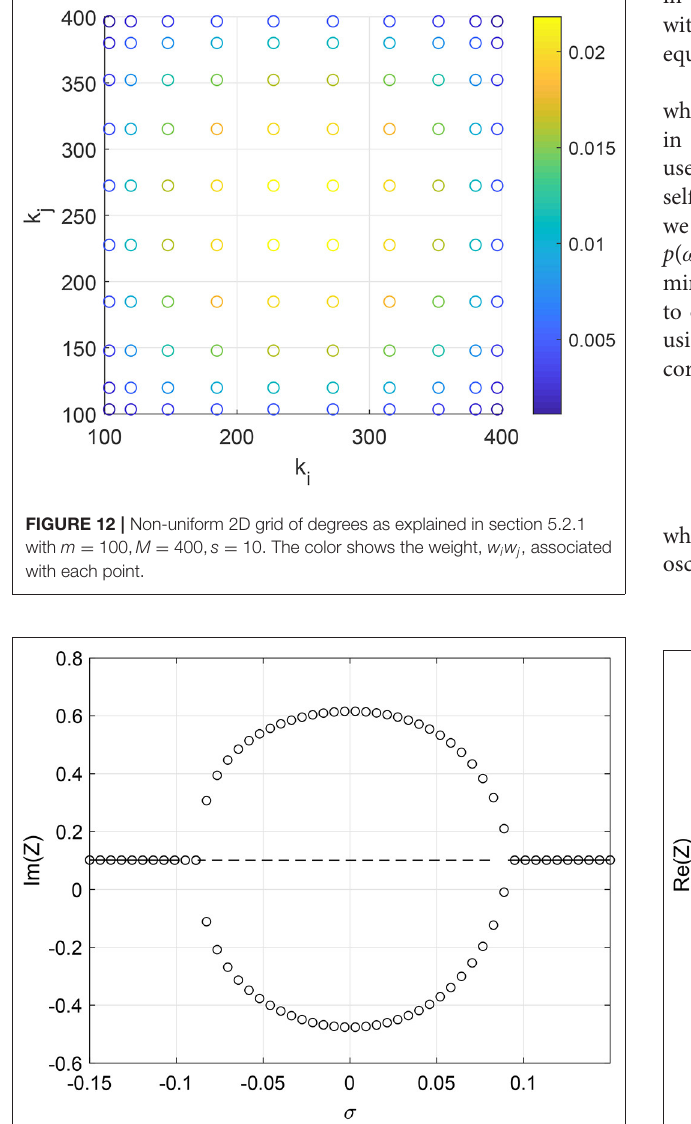
σ ˆ k out . Solid line: FIGURE 13 | Intrinsic frequency dependence ω 0 ( k out ) 1 = + stable fixed point of (44); dashed line: unstable fixed point. Circles: maximum and minimum over one period of Im( Z ). Other parameters: 1 0.05, β 0, ǫ 0.2, m 100, M 400. = = = = =